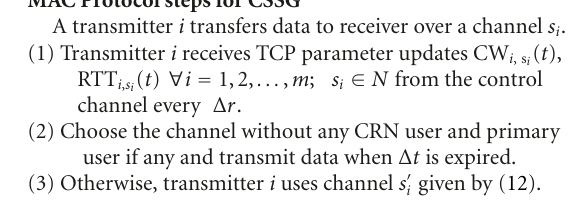
MAC Protocol steps for SSSG